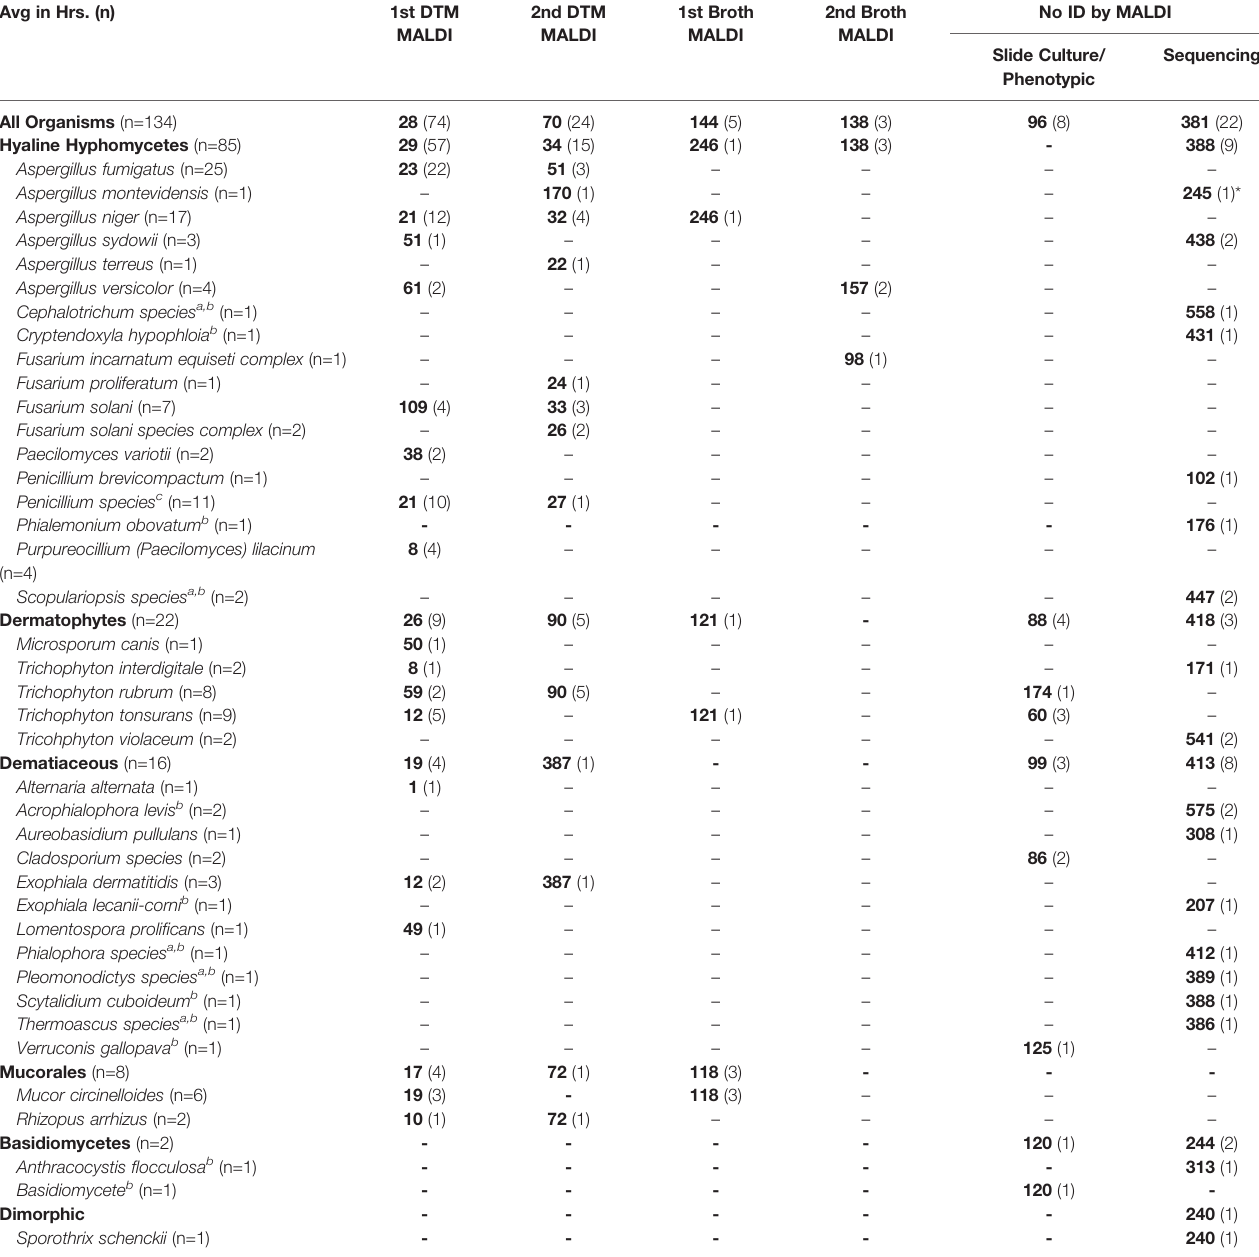
TABLE 2 | Hours to identi fi cation from initial colony